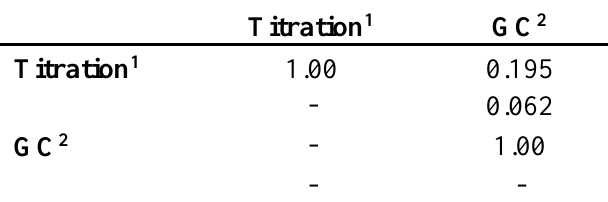
Table 13 . Pearson Correlation Coefficients and P-values for two measures of measures iodine value of jowl fat from pigs fed 20%